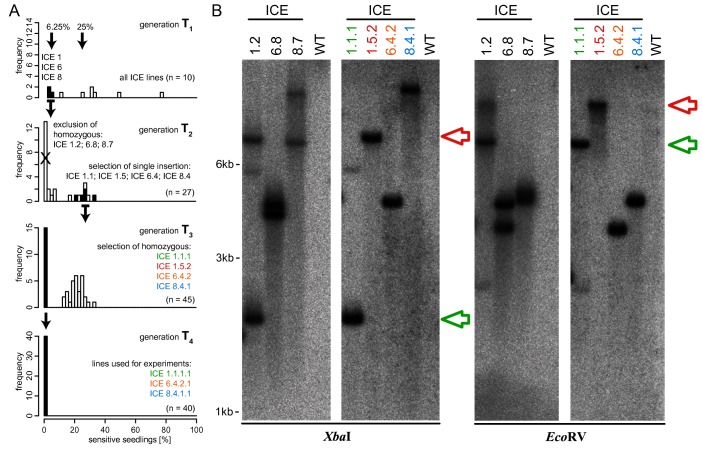
Selection scheme for ICE overexpression lines harboring a single copy of the transgene.(A) Segregation analysis of the resistance marker loci was determined by germinating seedlings of N. attenuata on antibiotic containing medium. Three lines from independent regeneration events (ICE 1, ICE 6 and ICE 8) indicated the presence of two T-DNA loci (T1 segregation rate aproximating 6.25%). The first homozygous generation (T2) harbored multiple insertions and was excluded from further analysis. Alternatively selected T2 plants with hemizygous segregation patterns (25% sensitive seedlings) were further propagated and resulted in plants with single T-DNA insertions that were used for experiments (T4 generation). (B) Southern blot analysis for the determination of T-DNA copy numbers as performed in Weinhold et al., 2013. Genomic DNA was isolated from homozygous seedlings and digested in separate reactions with XbaI or EcoRV. A radiolabeled fragment of the hygromycin resistance gene (hptII) served as probe. All plants used for experiments showed single T-DNA insertions. Coincidently, the two loci of line ICE 1.2 were separated by segregation and resulted in plants with insertions at different positions (ICE 1.1.1 and ICE 1.5.2 highlighted with a red and green arrow).